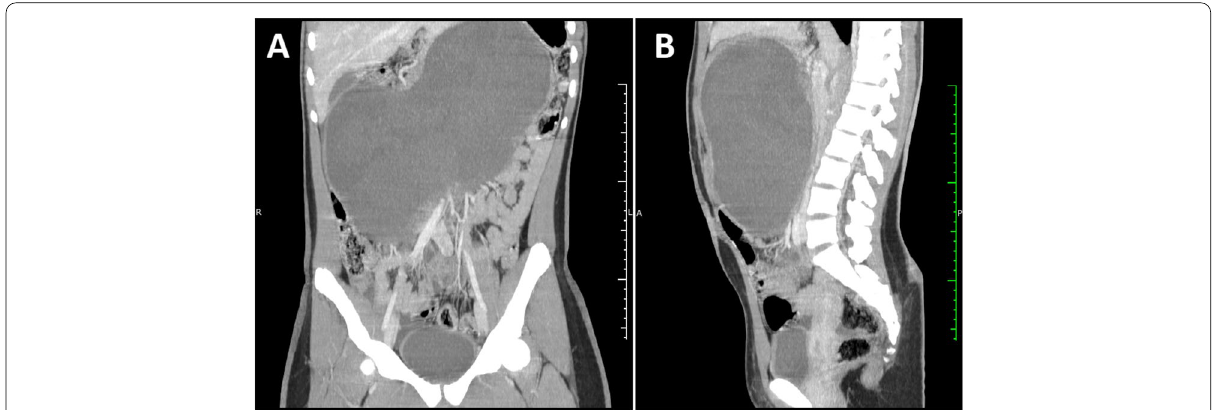
Fig. 1 Computerized tomography of the abdomen. A Contrast CT, late venous phase, showing a large cystic formation, in close relation to the lateral portion of the left liver lobe, dislocating the stomach, transverse colon, and small bowel loops. B It extends to the level of L4, with well defined limits, encapsulated, regular contours and no evidence of calcifications or fats inside